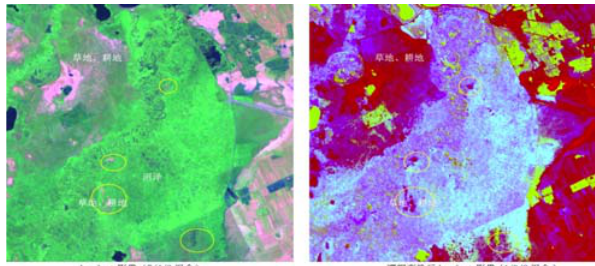
Figure 2. Image changes comparison of grassland, farmland and marshland